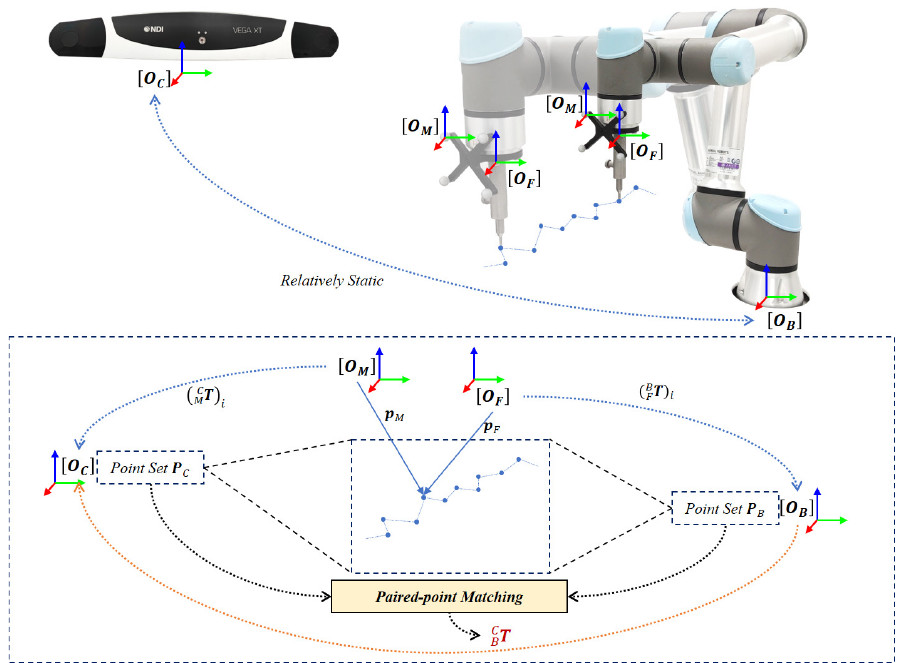
T via paired-point matching. By controlling the flange to move in m different Figure 3. Solving C B positions, we can obtain the coordinates of the tool tip in both the optical tracking camera COS O C T is solved by matching the two point sets and the robot base COS O B , generating two point sets. C B using a paired-point matching